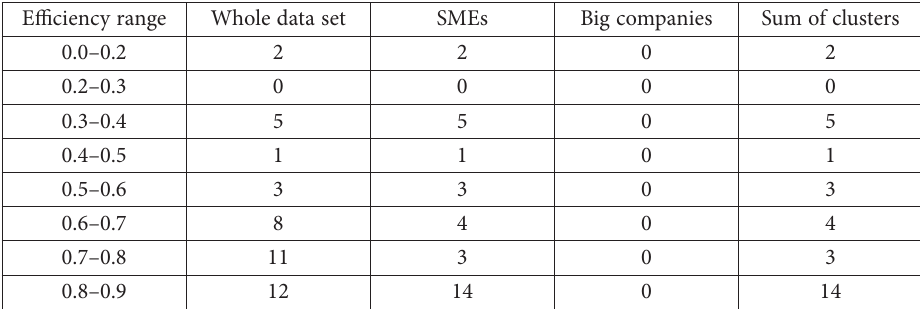
Table 6. Efficiency results before and after clustering (source: author’s calculation by R studio (average of 4 years)) Efficiency range Whole data